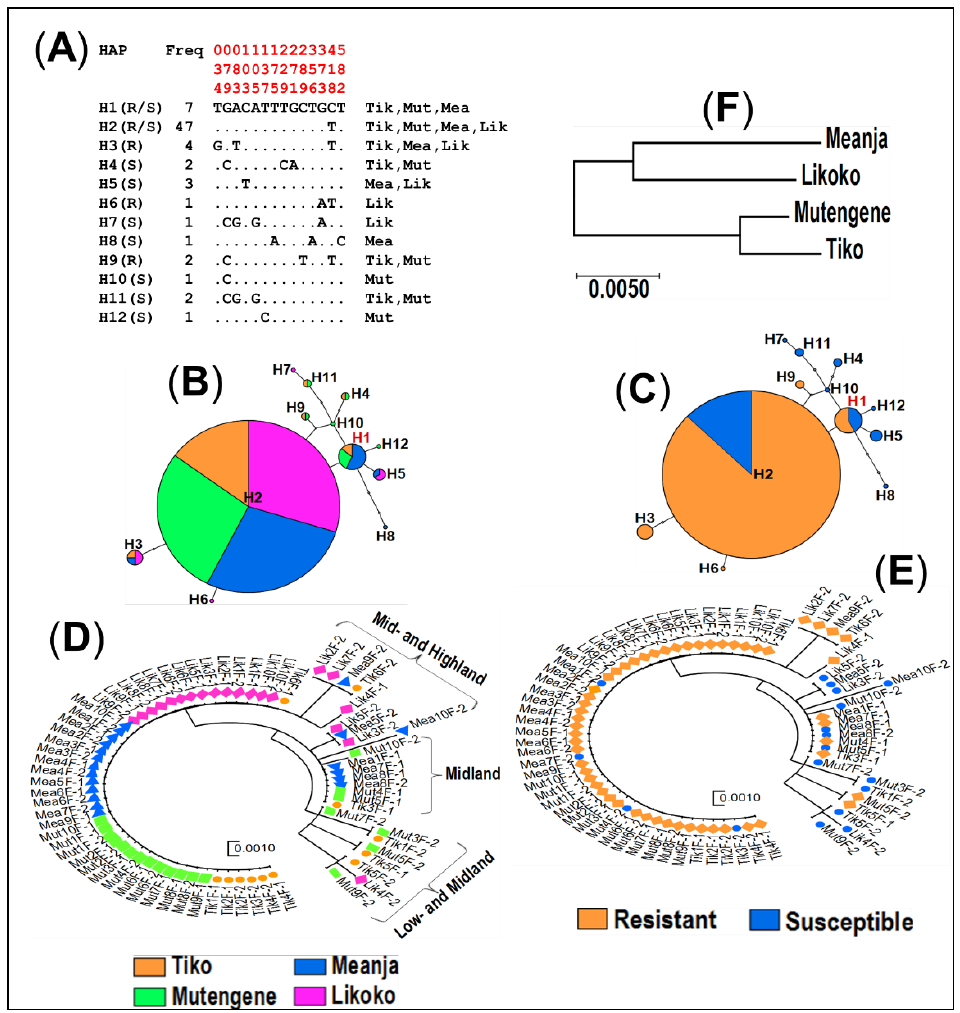
Figure 5. Genetic diversity and polymorphism patterns of GSTe2 DNA sequences across Mount Cameroon. ( A ) Haplotype diversity patterns of the 729bp GSTe2 fragment in Tiko (Tik), Mutengene (Mut), Meanja (Mea) and Likoko (Lik); H = haplotype; R = resistant; S = susceptible; polymorphic sites are in red. TCS haplotype networks showing haplotype’s generation within GSTe2 gene in An. funestus s.s with respect to localities ( B ) and allelic profiles ( C ): haplotypes are presented in circular shape scaled to reflect their respective frequencies; Ancestral haplotype in red. Maximum likelihood phylogenetic trees of GSTe2 DNA sequences among localities ( D ) and allelic profiles ( E ) showing an apparent separation between susceptible samples and resistant ones. ( F ) Neighbour-joining tree of the genetic distances showing a genetic relatedness to the landscape along the Mountain altitudinal transect with Tiko and Mutengene (9–220 m a.s.l., both located on the southwest edge) clustering together more than Likoko (800 m a.s.l., west edge) and Meanja (305 m a.s.l., eastern edge). Table 1. Genetic variability parameters of GSTe2 full mutation.